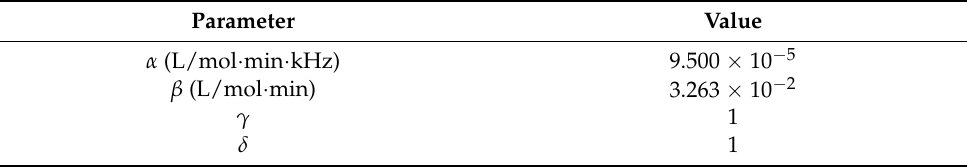
Table 7. Statistical summary of variance analysis of the proposed